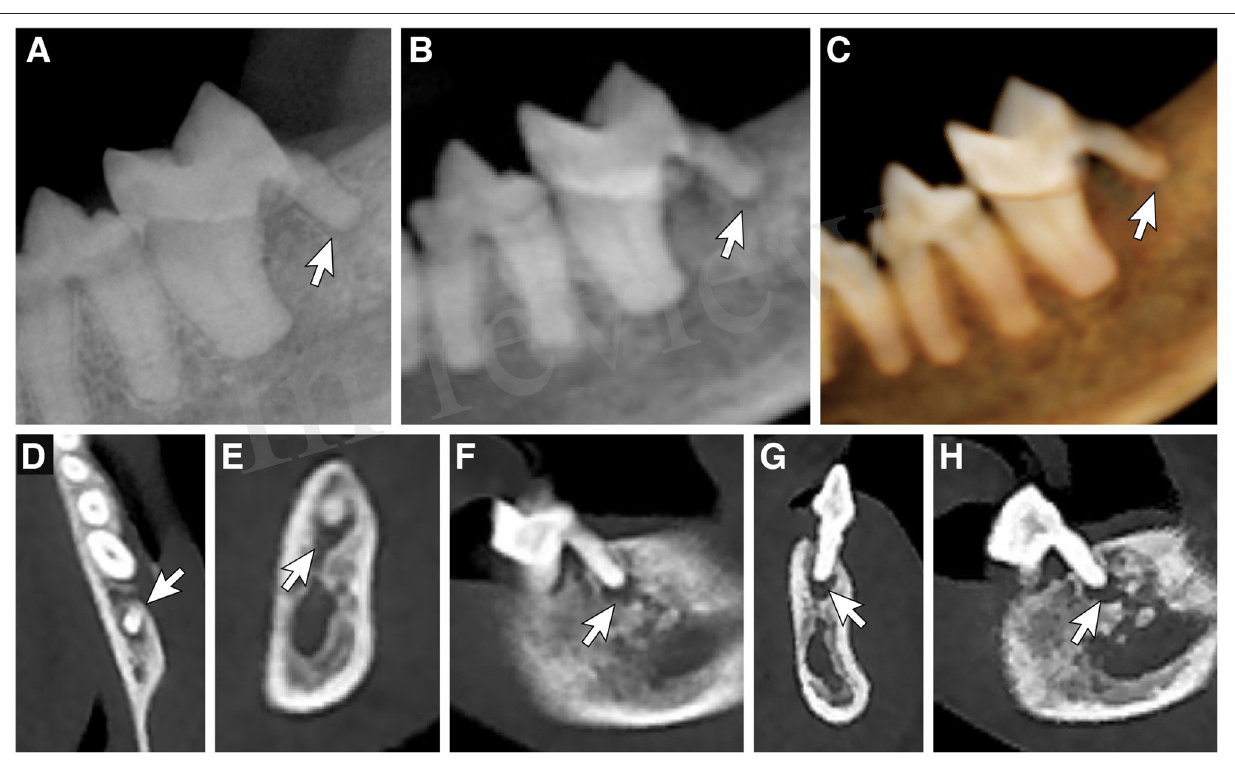
FIGURE 6 | Periapical lesion. Evaluation of the presence of a periapical lesion associated with the distal root of the left mandibular first molar tooth by way of (A) a dental radiograph obtained with the intraoral, parallel radiographic technique, (B) reconstructed panoramic CBCT viewing method with the axis of the skull adjusted for orientation of the left mandibular third premolar tooth through first molar tooth, (C) tridimensional (3-D) rendering CBCT viewing method in tooth mode, (D) axial section multiplanar reconstruction showing apex of the distal root, (E) coronal section multiplanar reconstruction of the distal root, (F) sagittal section multiplanar reconstruction of the distal root, (G,H) custom cross-section multiplanar reconstructions of the distal